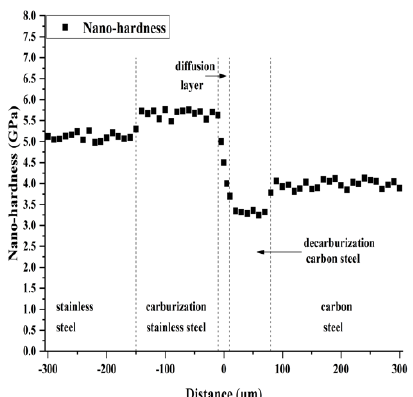
Figure 5. The nano-hardness distribution of stainless steel clad plate.